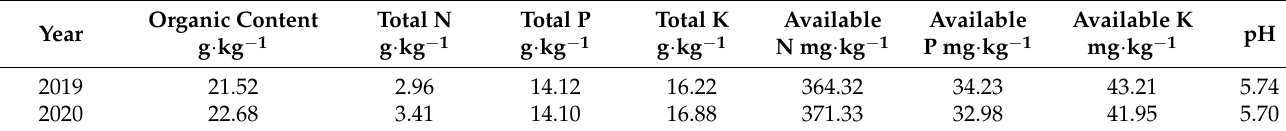
Table 1. Physical and chemical properties of the soil.